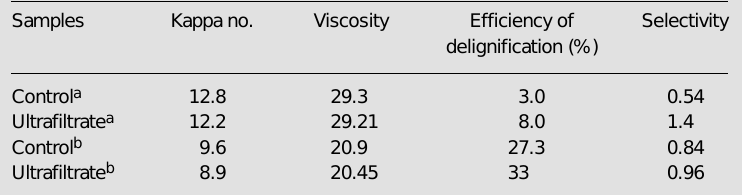
The unbleached pulp had kappa number of 13.2 and viscosity of 31.0 cp before treatment. a Pulp prebleaching. b Pulp bleaching followed by alkaline, oxygen and hydrogen peroxide